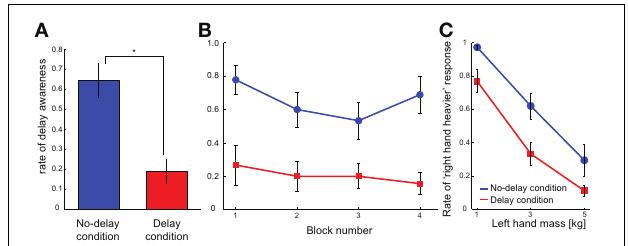
FIGURE 4 | Results of Experiment 2. (A) Average delay awareness across participants is shown in each condition. * p < 0 . 05 according to the paired t -test. (B) Rate of the delay awareness is shown as a function of block number. (C) Average judgment of “right hand heavier” across participants is shown for each right-hand mass value in each condition. Error bars indicate standard error of measures across